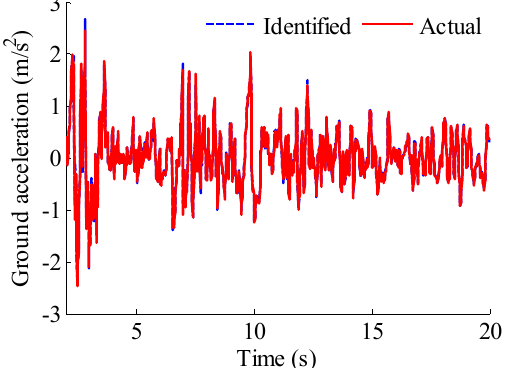
Figure 8. Identified ground acceleration using 900 sample points.